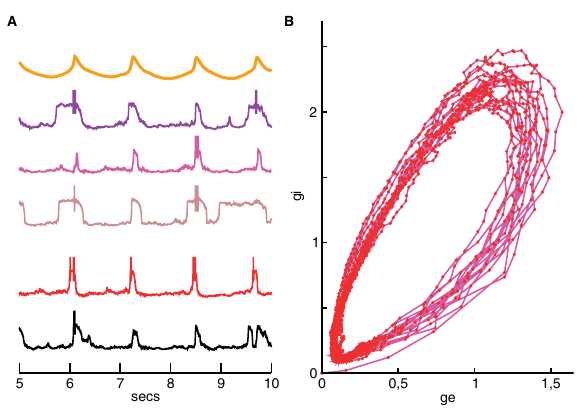
Figure 4. ( A ) A more synchronous network . The distribution of the mem- brane threshold and some of the unitary conductances have been changed to induce more synchronous transitions. The synaptic inhibitory conductances were 70% of those described in the Methods. In addition, ∆g syn,I = 0 . 197 and V th = − 45 . 5 ± 2 . Note the sharp increase in the average membrane potential (top trace) correlated with neuron firing, which is similar to the LFP observed in (Destexhe et al., 1999). (B) Evolution of the average conductances in the regular network of Figures 2 and 3 . The average inhibitory synaptic conductance gi versus the average excitatory synaptic conductance ge, with time as an implicit parameter. The red dots indicate the data at the sampling times. Both conductances increase as the network makes a transition from the down to the up state.